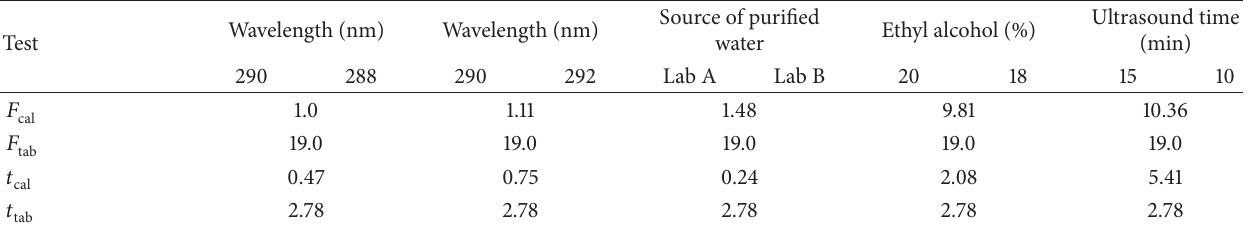
Table 5: Calculated values through the 𝐹 and 𝑡 -tests to variations of absorption spectrophotometric method in the ultraviolet region for determination of rifaximin in tablet.